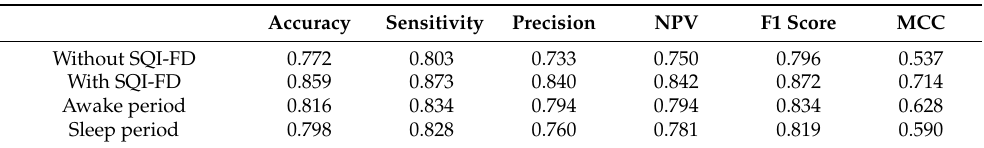
Table 5. Major depressive disorder screening performance with and without thresholding using signal quality indices in the frequency domain